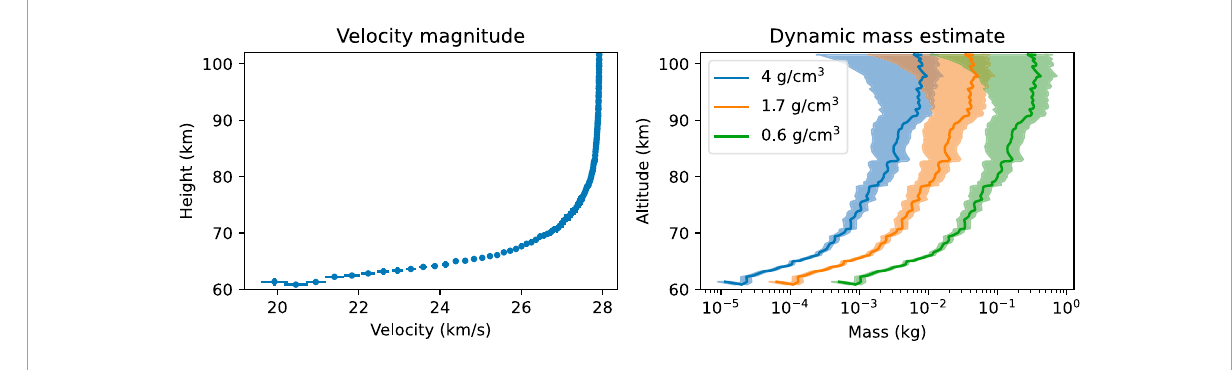
FIGURE 5 Left: The absolute magnitude of the measured velocity as a function of altitude. Two standard deviation errors in velocity and height are indicated. Right: Three different dynamic masses estimated from the meteor trajectory. The error estimates are two standard deviations.